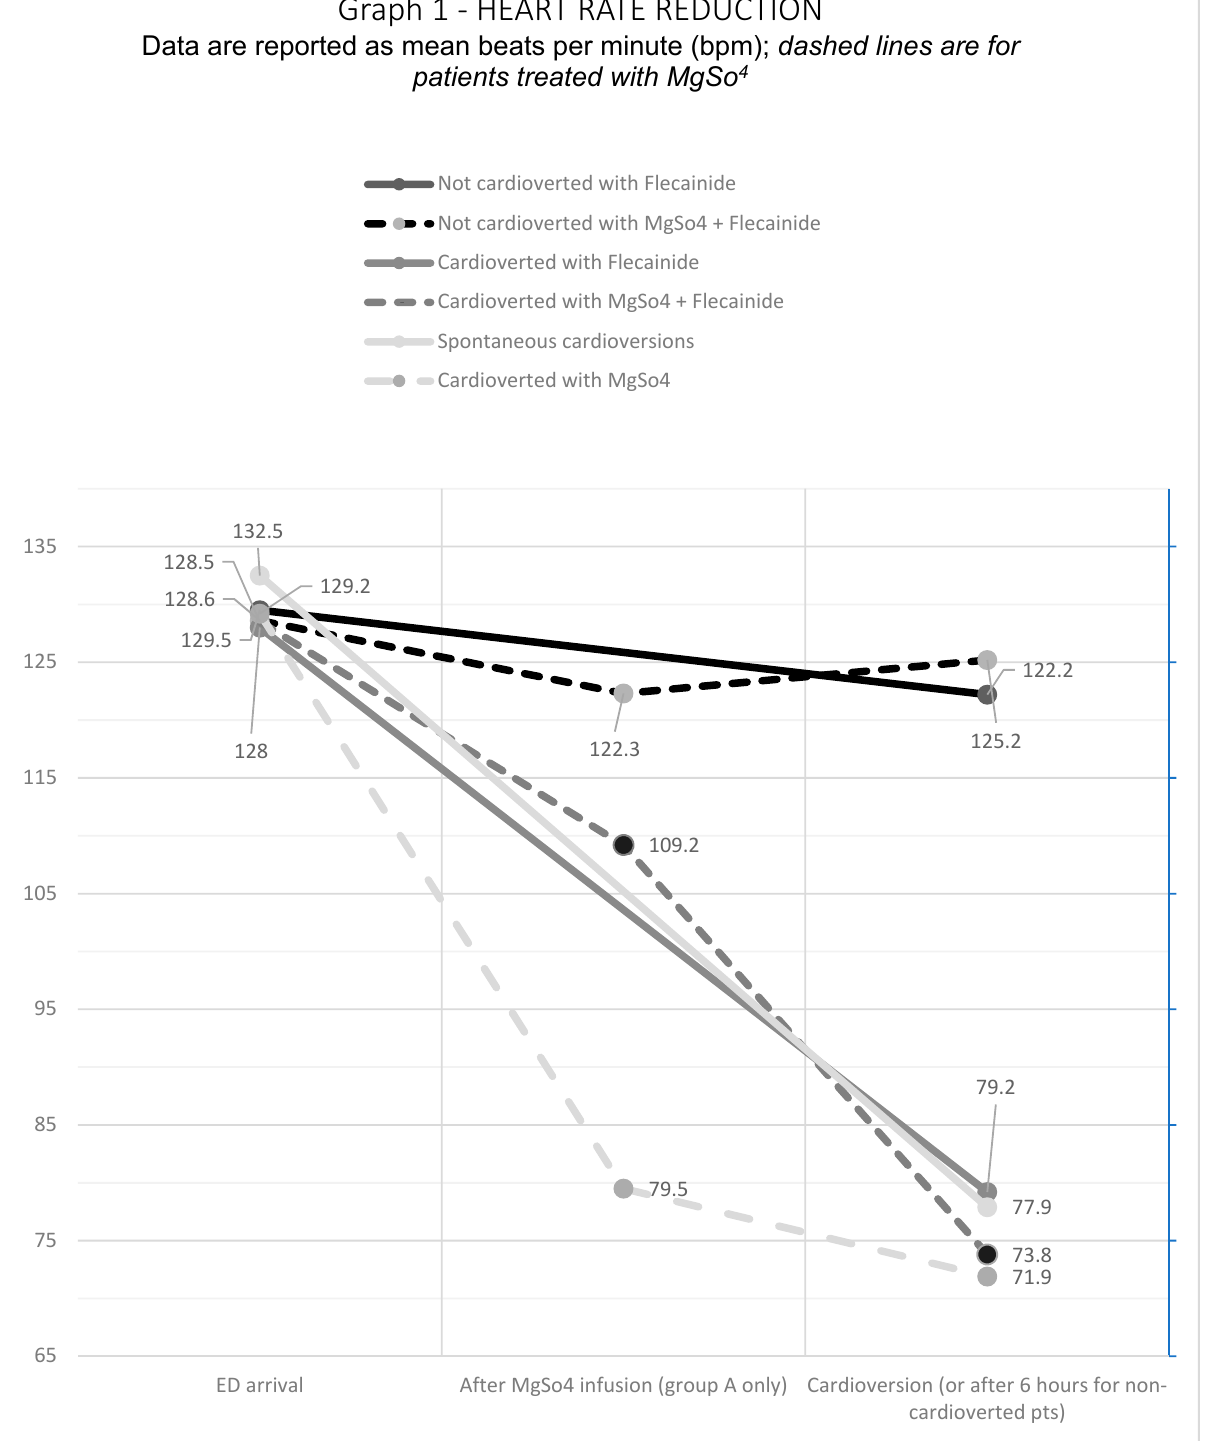
Figure 1. Heart Rate Reduction.